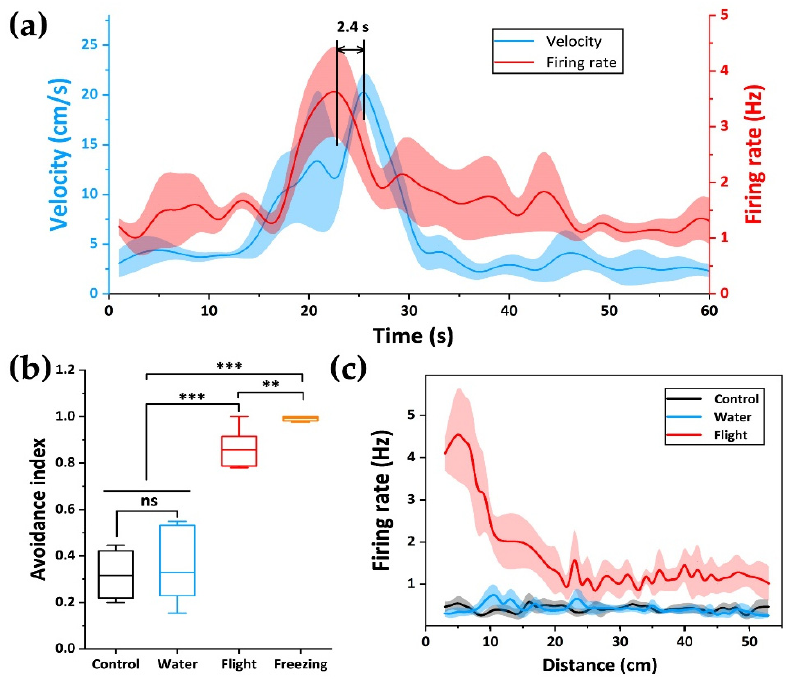
Figure 5. The correlation between neurons and the flight behavior of rats during flight. ( a ) firing activity of neuron and the rats’ instantaneous velocity during flight. The data were the average speed in every 0.5 s; ( b ) avoidance index during four different periods. The middle line of the boxplot was the mean line; ( c ) firing rate plotted as a function of distance to the filter paper during control (black), water (blue) and flight (red). Firing rate was inversely proportional to distance during flight. Results were expressed as mean ± SEM. Statistical analysis was performed using Student’s t -test. ** p < 0.01, and *** p < 0.001.